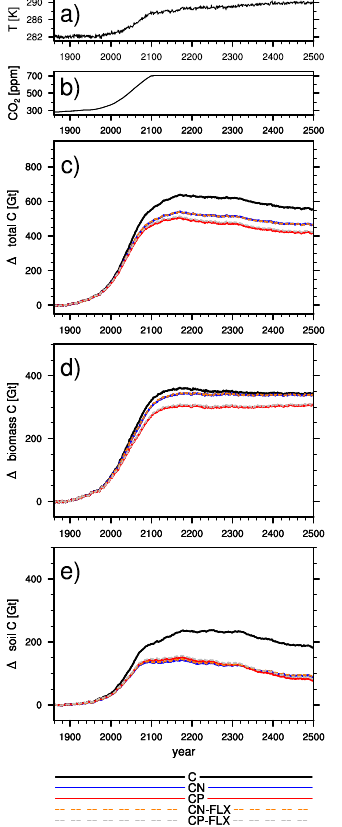
Fig. C1. The simulated change in land carbon storage under the SRES A1B scenario. Shown are the 10-yr mean of soil temperature (a) , the CO 2 concentration as used in the forcing simulation (b) , the resulting change in total land C storage (c) , and the changes in the two main land compartments, vegetation (d) and soil (e) . CN-FLX and CP-FLX are the new simulations with flexible plant stoichiom- etry.